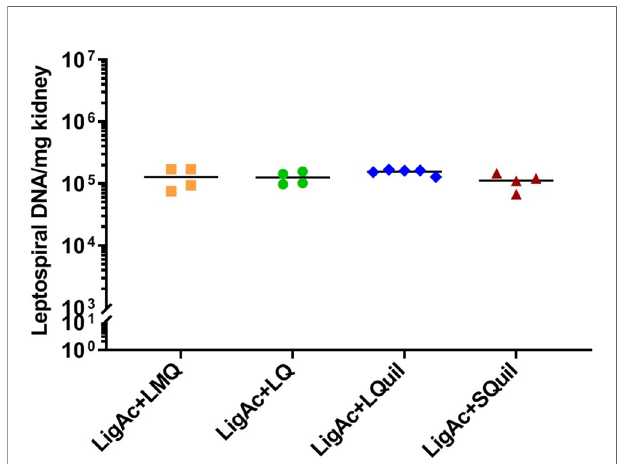
FIGURE 4 | Kaplan – Meier plot of survival rates in vaccinated hamsters (n = 8 per group) following lethal challenge by virulent Leptospira . The hamsters were immunized with various vaccine formulations shown in the Supplementary Table . Each vaccinated hamster was challenged by 100× LD 50 of low passage leptospires. The percentage of survival was calculated as the number of survivors/total challenged hamsters ×100. Statistical analysis of survival rates between the negative control group and other vaccinated groups was performed by log-rank test; ** represents p < 0.01 (negative control group and vaccinated groups) and ## represents p < 0.01 (LigAc alone group and other vaccinated